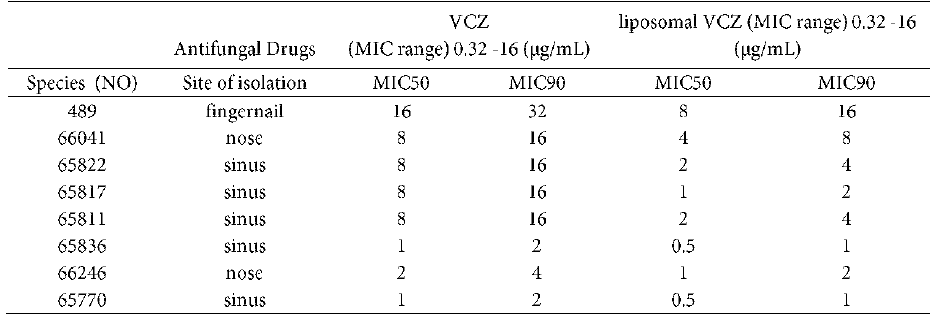
Table 2. MIC50 and MIC90 values for VCZ and liposomal VCZ in the isolates of A. flavus. (Mean range) 0.32 -16